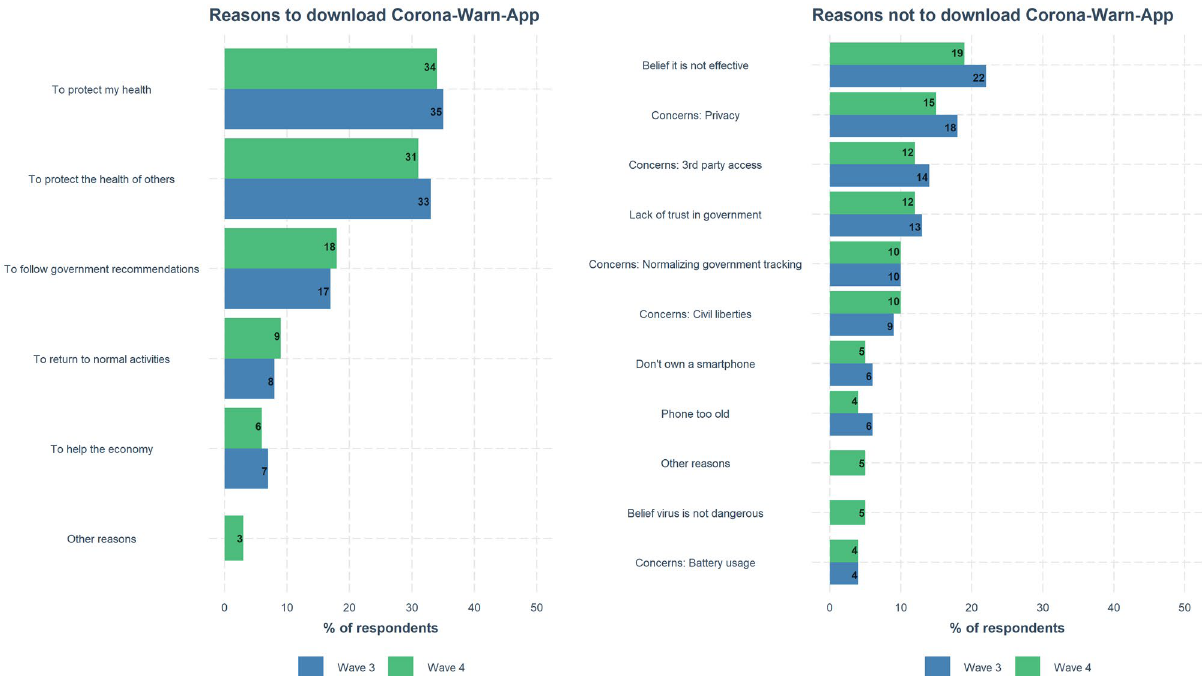
Figure 8. Self-reported reasons to download or not download the Corona-Warn-App. Panels show results of multiple-choice items in Waves 3 and 4. By design, there are more response options for both questions in Wave 4 than in Wave 3. See Supplementary Table B7 for the wording of the items.